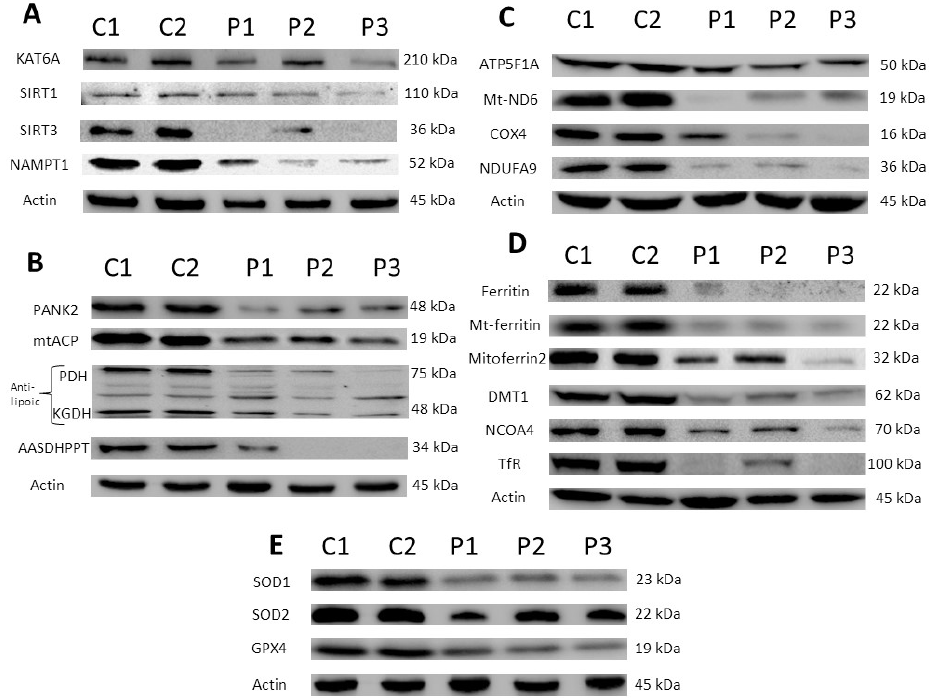
Figure 1. Protein expression patterns in control and KAT6A mutant fibroblasts. Protein extracts of Control (C1 and C2) and patient (P1, P2 and P3) cell lines were separated on an SDS polyacrylamide gel and immunostained with primary antibodies. ( A ) Proteins related to acetylation-deacetylation reactions: KAT6A, SIRT1, SIRT3, and NAMPT1; ( B ) proteins related to CoA metabolism: PANK2, mtACP, lipoylated PDH, lipoylated KGDH, and AASDHPPT; ( C ) mitochondrial proteins: ATP Syntase, Mt-NAD6, COX4 subunit, and NDUFA9; ( D ) proteins related to iron metabolism: ferritin, Mt-ferritin, mitoferrin 2, DMT1; NCOA4, and TfR; ( E ) antioxidant enzymes. A representative actin lane is shown, although loading control was additionally checked for every Western blot. Data represent the mean ± SD of three separate experiments. Quantification of protein bands using densitometry is shown in Supplementary Figures S1 and S2.